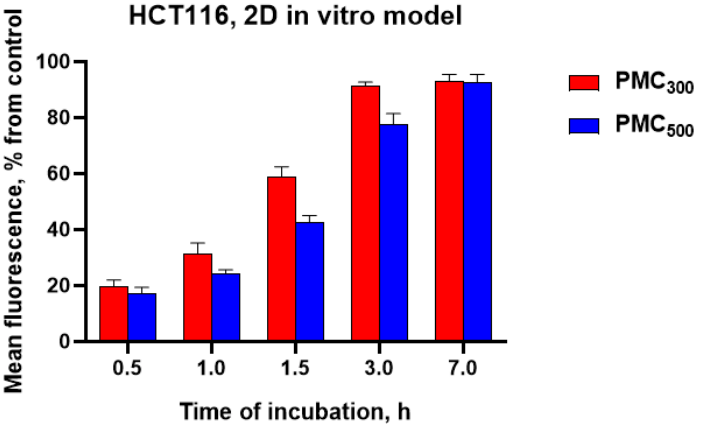
Figure 6. The accumulation levels of PMC 300 and PMC 500 loaded with DOX in HCT116 cells after 5, 30 and 60 min incubation. Monolayer cell culture. Flow cytometry.